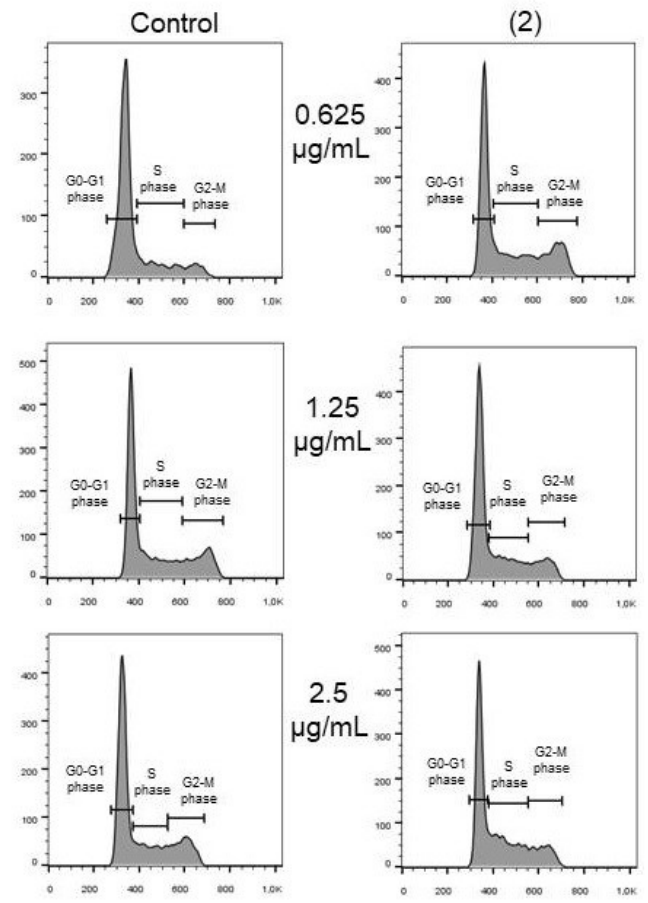
Figure 5. E ff ects of compound 2 on OCI-AML3 cell cycle progression. ( A ) Bars represent the percentage of cells in G0 / G1 (left panel), S (middle panel), or G2 / M (right panel) phases after 24 h of treatment with control vehicle (Control) or 0.625 [(2) 0.625], 1.25 [(2) 2.25] or 2.5 [(2) 2.5] µ g / mL of compound 2 . ( B ) Flow cytometry analyses of a representative experiment. Data from three independent experiments are reported as mean ± SEM. * p < 0.05, ** p < 0.01.